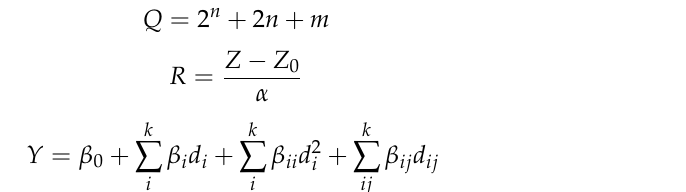
Table 1. The compressive strength ( CS ), tensile strength ( TS ), and flexural strength ( FS ) of the GBFS-based SCACC containing CWP exposed to ambient conditions was evaluated in the first model at time intervals of 3 to 56 days. The second model was developed to determine the optimal strength loss ( SL ), weight loss ( WL ), and ultrasonic pulse velocity